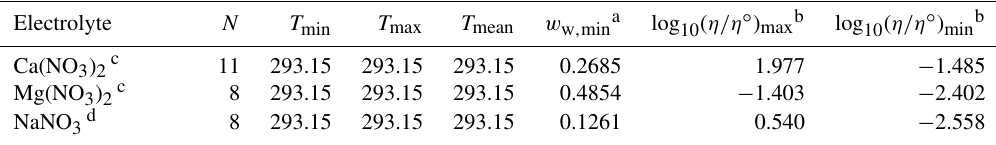
Table 5. Data set information for droplet-based measurements of binary aqueous electrolyte mixtures used to fit the AIOMFAC-VISC electrolyte